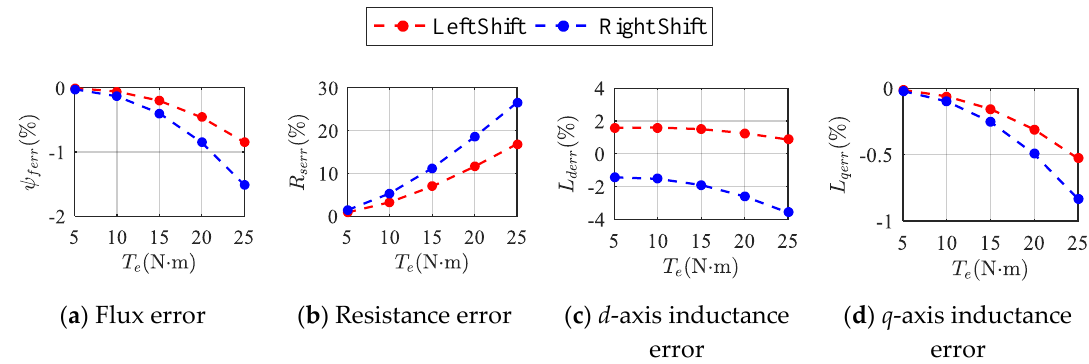
Figure 4. Theoretical results for left and right shifts of the operating point with different torques.